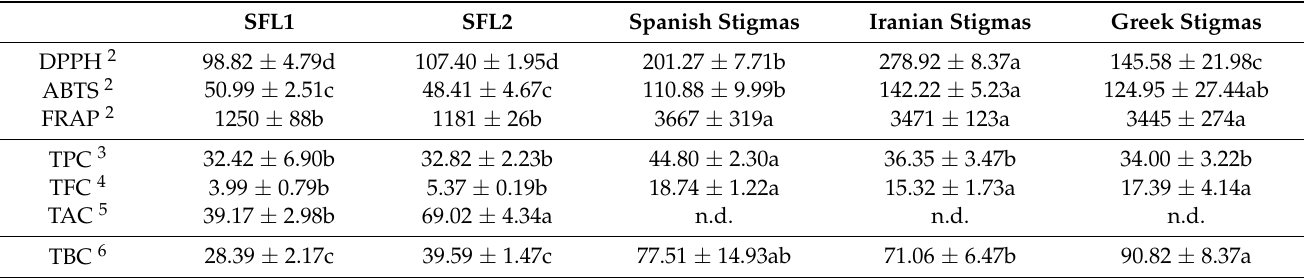
Table 1. Antioxidant capacity and bioactive compounds content in saffron floral by-products and stigmas 1 .